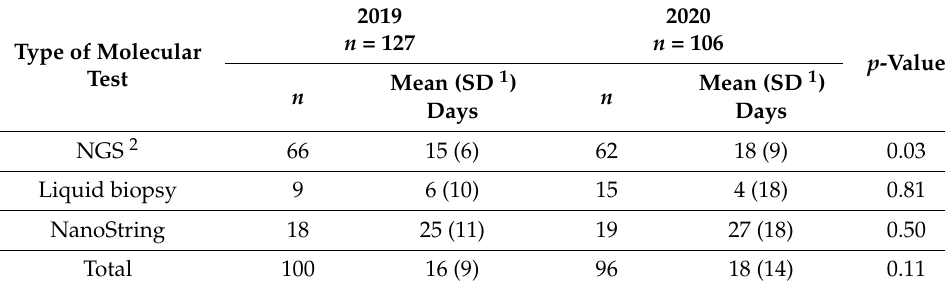
Table 6. Mean wait time for molecular